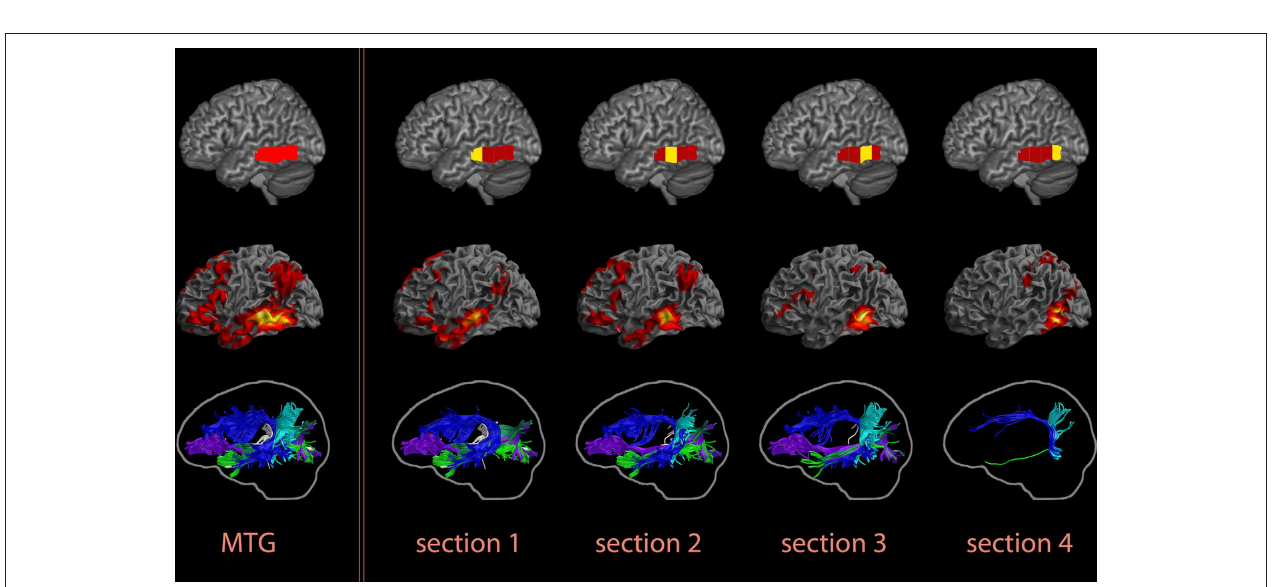
Figure 13 | Fiber pathways passing through the white matter underlying the superior temporal sulcus. Five different fiber bundles were found to contribute fibers to this small white matter region (left, green). Direct and